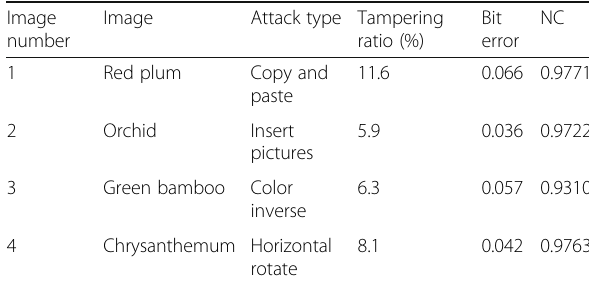
Table 2 Experiments for Green bamboo